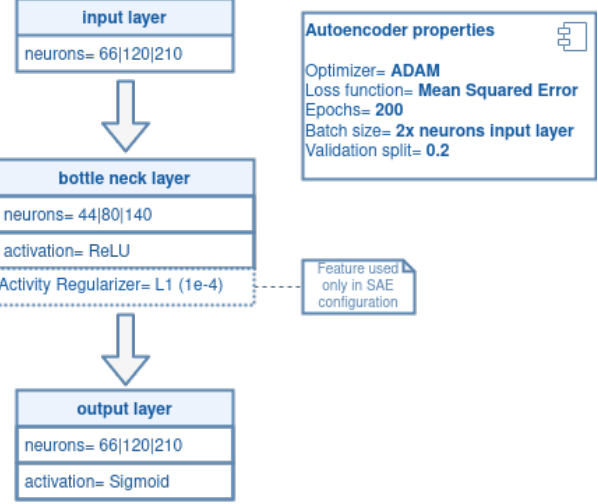
Figure 9. Autoencoder and SAE